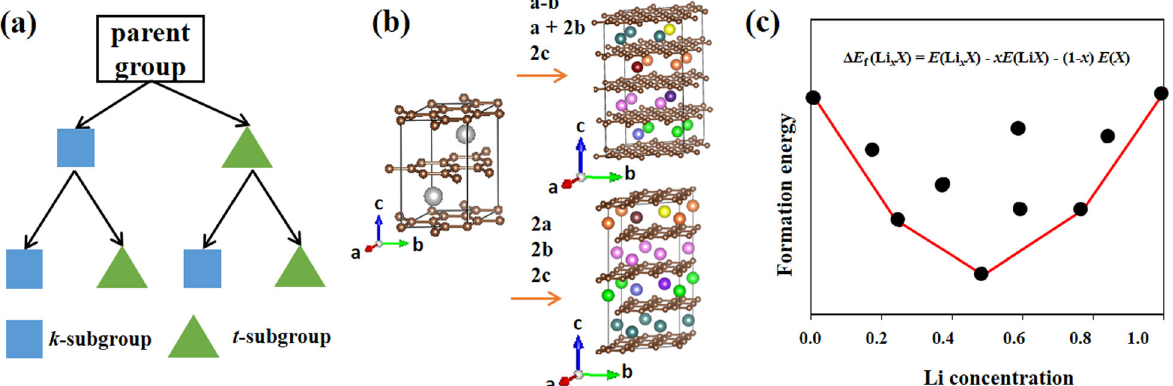
Fig. 9 Application of group – subgroup transformation for prediction of the ordered ground states. a Determination of subgroups and corresponding transformation matrix of the parent space group according to CELLSUB . b Subgroup structures are obtained by TRANSTRU with transformation matrix as an input. The splitting of Li position is illustrated by different colors. Vacancy and Li can occupy independent sites (illustrated by Li x C 6 ). c Formation energies are obtained by fi rst-principles calculations, and ordered ground states are determined by the convex